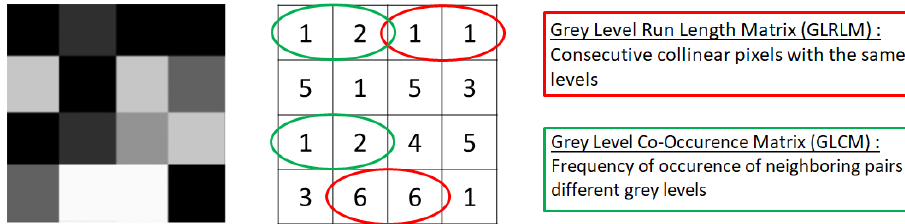
Figure 2. Example of two second-order radiomics features, Gray-Level Run-Length Matrix (GLRLM) and Gray-Level Co-occurrence Matrix (GLCM).